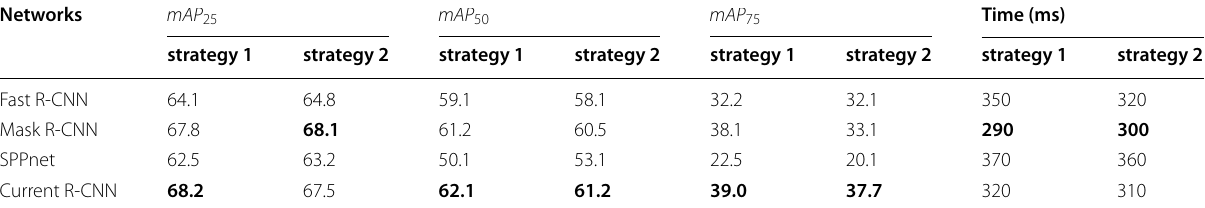
The highest mAP and the shortest time are presented in bold font. The mAP 25 mAP 50 , mAP 75 are mAP s with th IoU of 25% , 50% and 75%